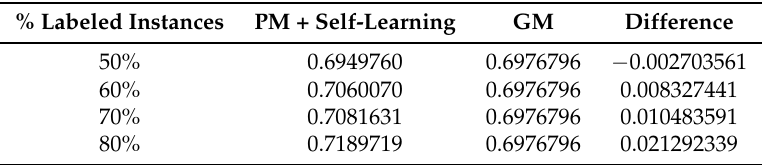
Table 7. D2: Wrist sensor dataset accuracies for varying % of labeled instances with self-learning (PM + self-learning) and the General Model (GM).